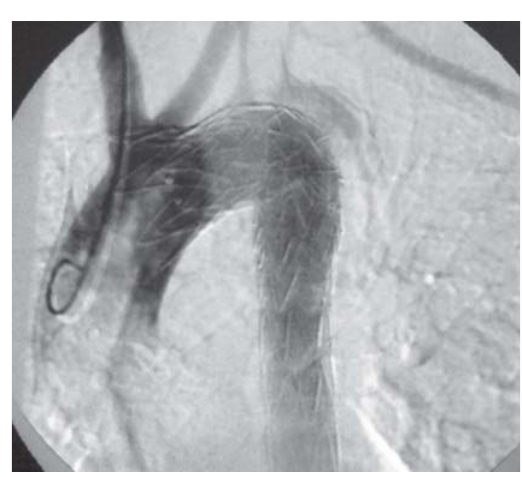
Fig. 2 – Aortografia mostando dissecção de aorta tratada com prótese auto-expansível (Stent) Braile Biomédica com